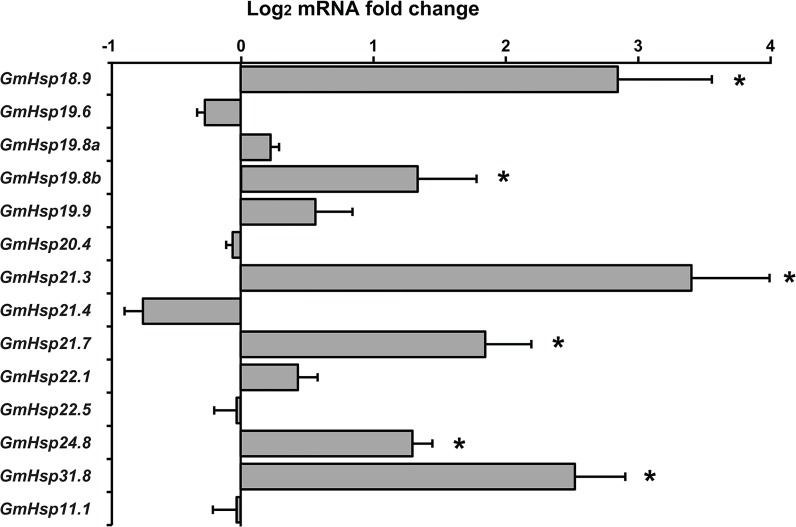
Mean normalized expression (with standard errors) of fourteen GmHsps in diapausing G. molesta.The values were based on log2 transformation of RT-qPCR of the assayed Hsps. Asterisks indicate mean values that are significantly (P < 0.01) different in 5th instar larvae between diapausing and control groups. A value of 0 indicates no difference in expression, whereas positive and negative values indicate upregulation and downregulation respectively.